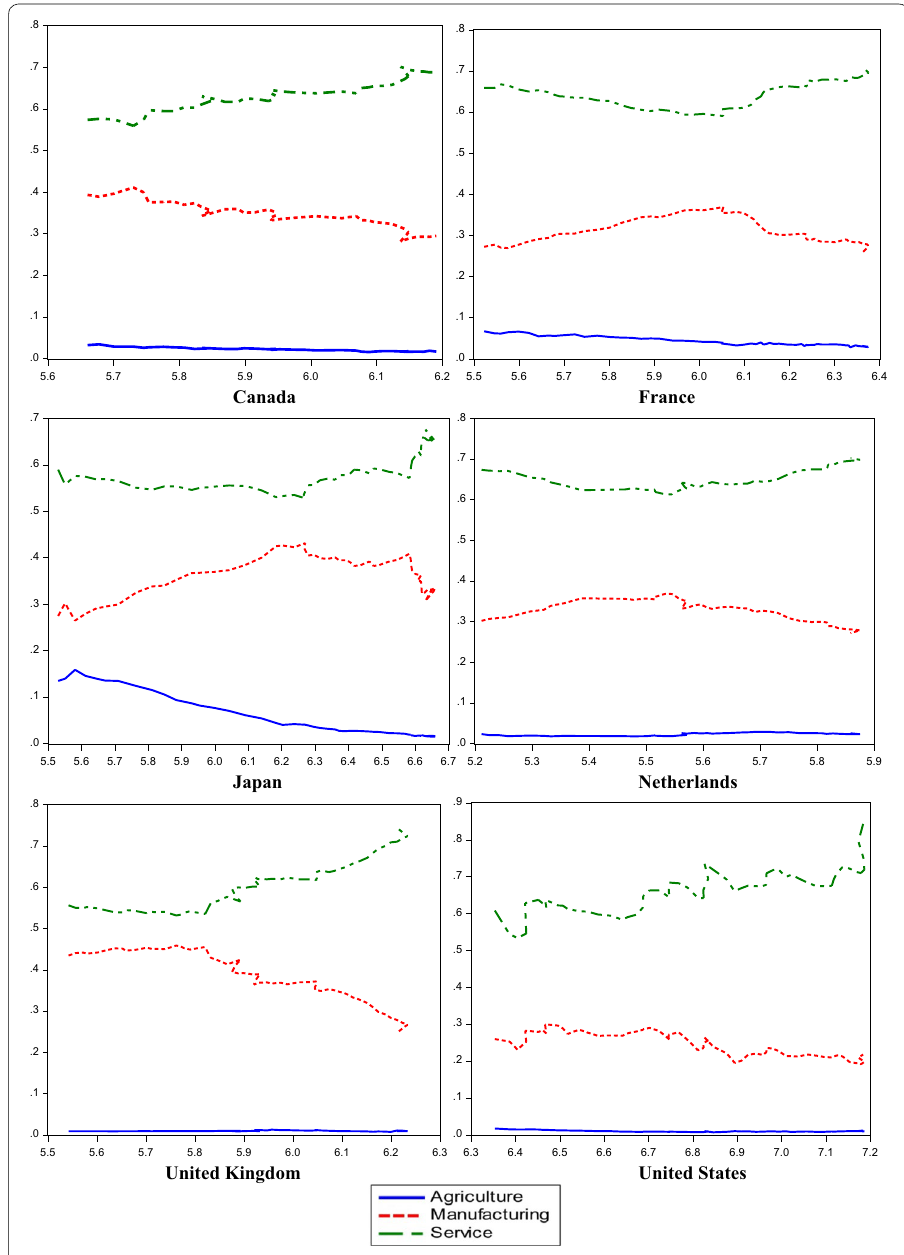
Fig. 6 Sectoral shares of value-added in the three sectors, and GDP in developed countries. Note : Horizontal line is Log (real GDP). Source : Author’s calculations. Various sources were used to collect data. For Canada, UN data (national currency) was used between 1970 and 2014. For other countries, value-added at national prices (2005 100) were derived from Groningen Growth and Development Centre: For France the period = 1950–2009; for Japan the period 1953–2011; for Netherlands the period 1960–2009; for the United Kingdom the period 1949–2009; for the United States 1950–2010. For additional information see Fig.